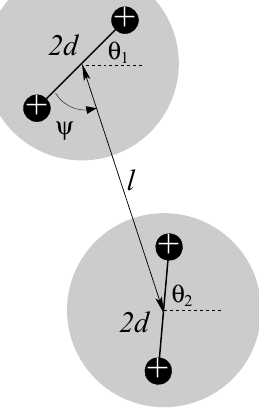
Fig. 1 – Schematic view of charged dimers in two different traps (shaded circles). l is the distance between the neighboring traps, 2 d is the size of the “colloidal molecule” and θ 1 , 2 are the characteristic angles. The large distance potential created by the upper dimer in the direction of the second one is given by Eq. (1), where the angle ψ is shown on the